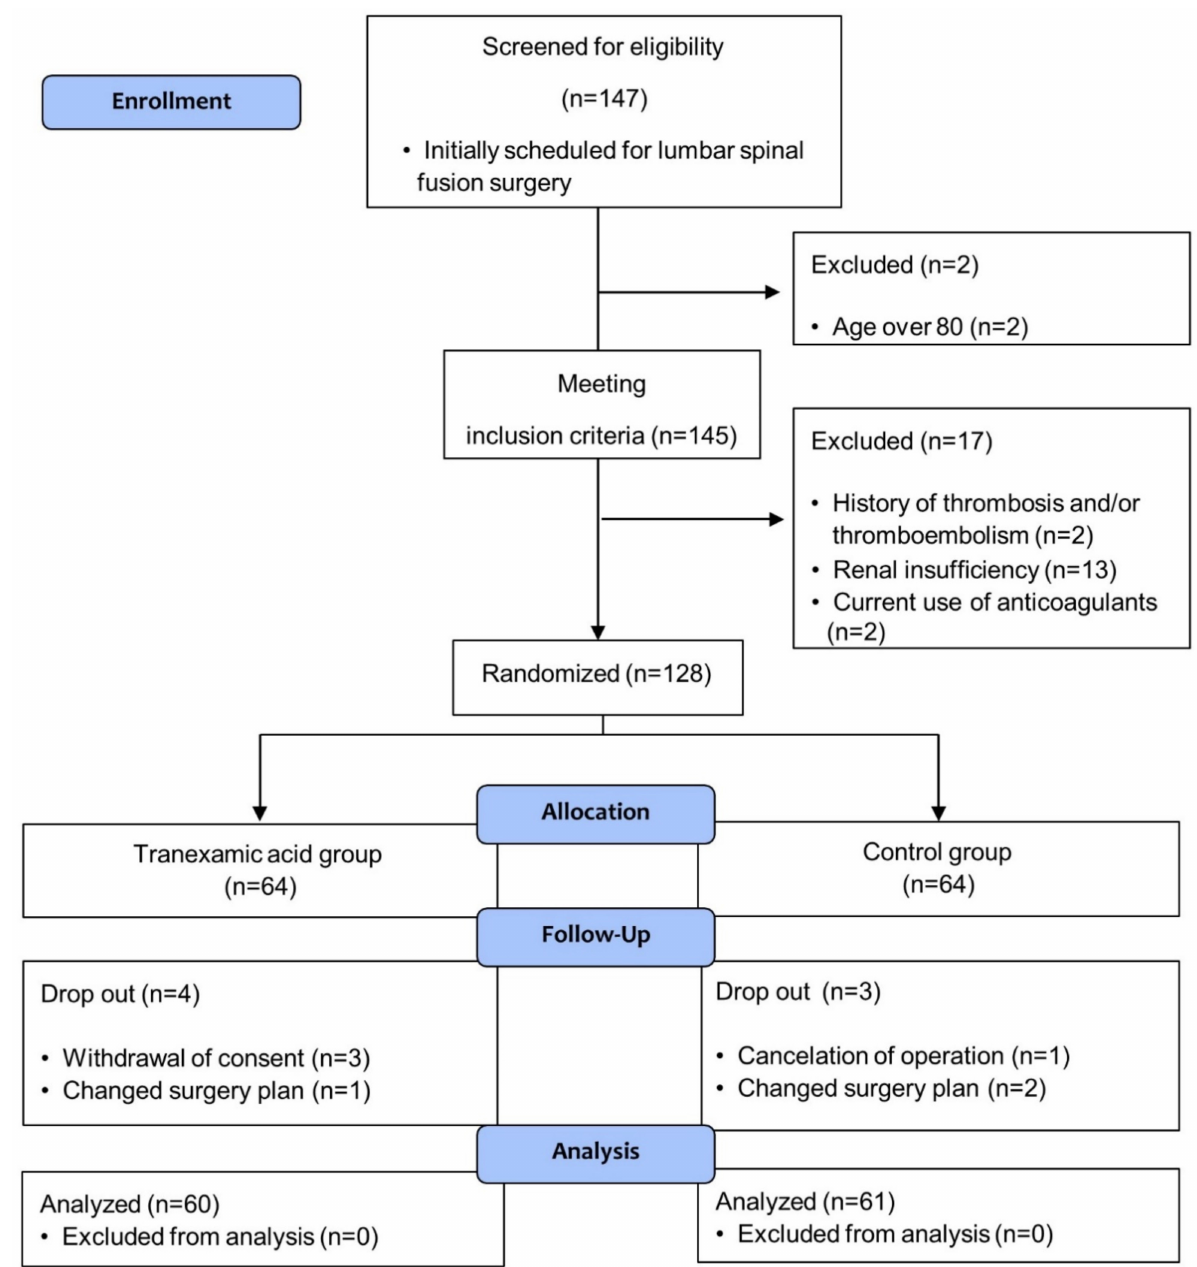
Figure 1. Flow chart of patient